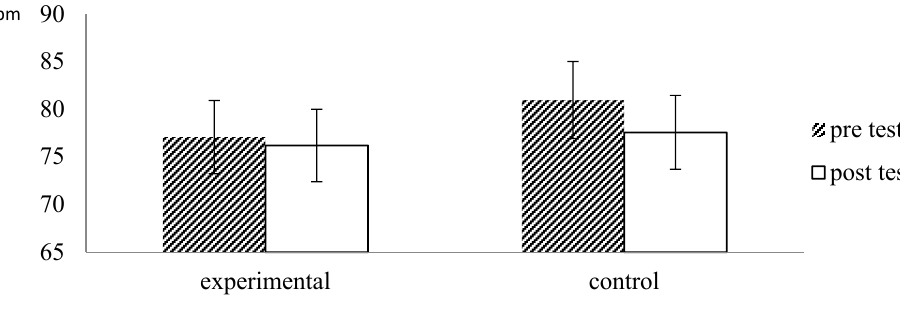
Figure 4. Effects of forest therapy on HR. Figure 4. Effect on forest therapy on HR.